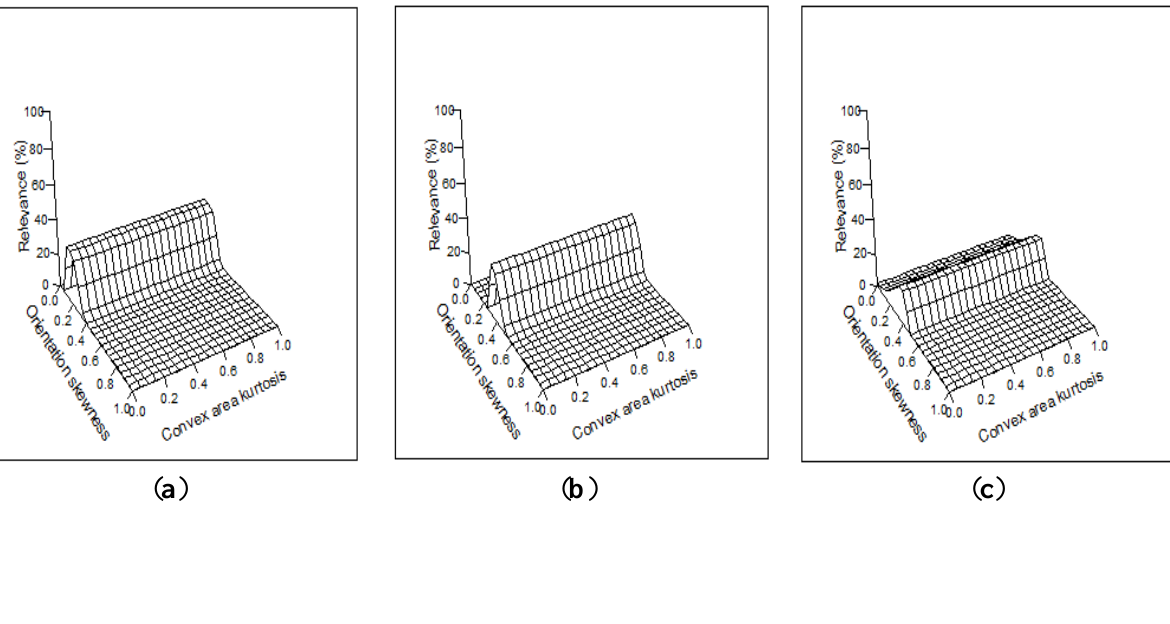
Figure 1. Example of a sequence of genetic operations: ( a ) random; ( b ) exon shift lambda 1; ( c ) exon shift lambda 2; ( d ) gene growth mutation; ( e ) gene relevance mutation; ( f ) gene constant mutation; ( g ) gene cross by replacing the second exon in (e) with the first exon in (a); ( h ) gene shrink mutation; ( i ) chromosome growth mutation; ( j ) chromosome constant mutation; ( k ) chromosome cross over with first gene at (d); ( l ) chromosome shrink